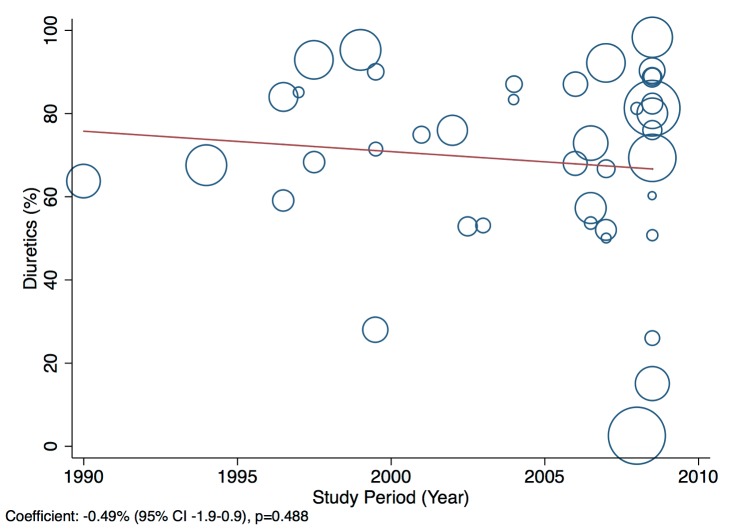
Meta-regression of diuretic use against study period.